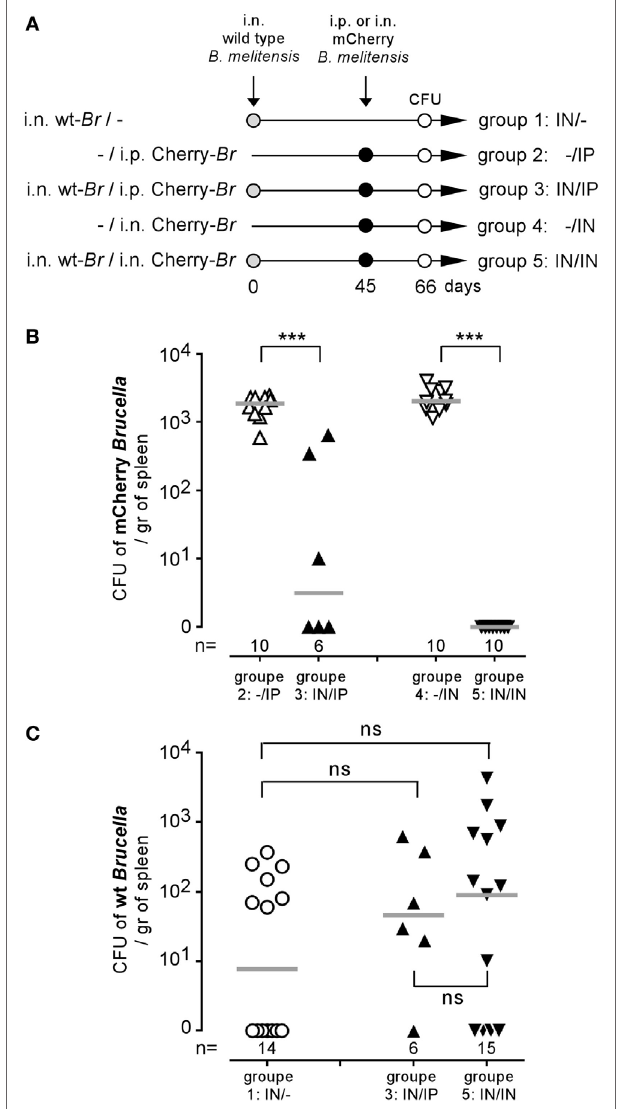
FigUre 2 | Brucella reservoir cells were resistant to the protective memory response. Wild-type C57BL/6 mice were infected i.n. with 2 × 10 4 CFU of wild-type Brucella melitensis and challenged i.p. or i.n. with 2 × 10 4 CFU of mCherry- B. melitensis. The mice were euthanized at the selected time, and the spleen was harvested, as described in panel (a) . The data in panels (B,c) represent the number of colony-forming units per gram of spleen for each group of mice. Gray bars represent the median. n denotes the number of mice used for each group (*** p < 0.001). These results are representative of at least two independent